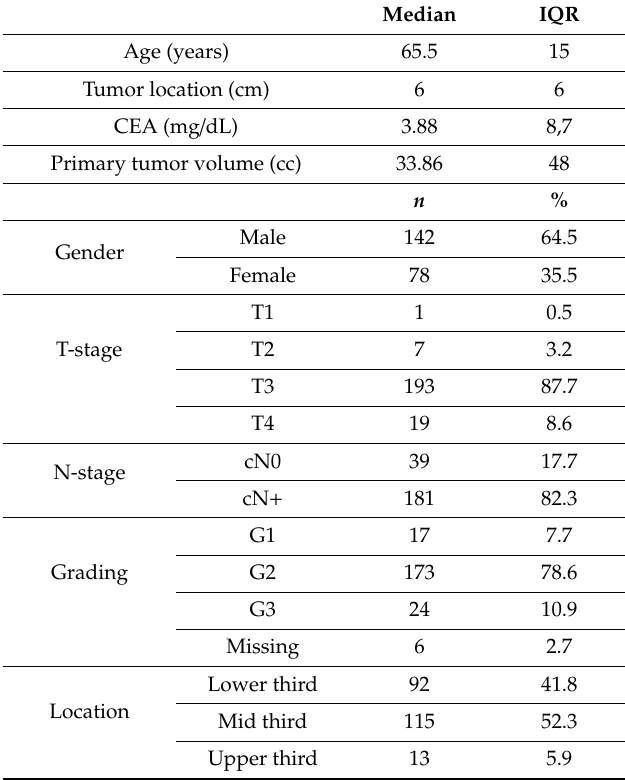
Table 1. Patient- and tumor-related